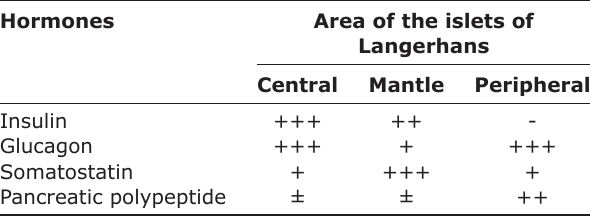
Table-1: Semiquantitative number of the endocrine cell types in the islets of Langerhans areas of the Sunda porcupine ( Hystrix javanica ).